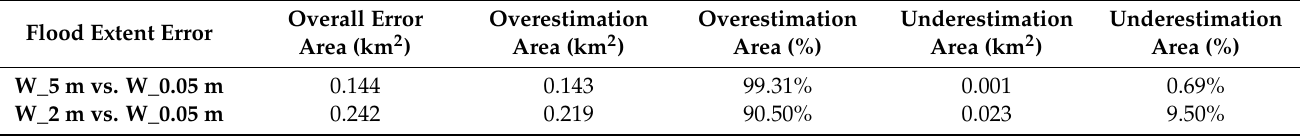
Table 4. Flood extent and flow depth statistics for the three simulations.